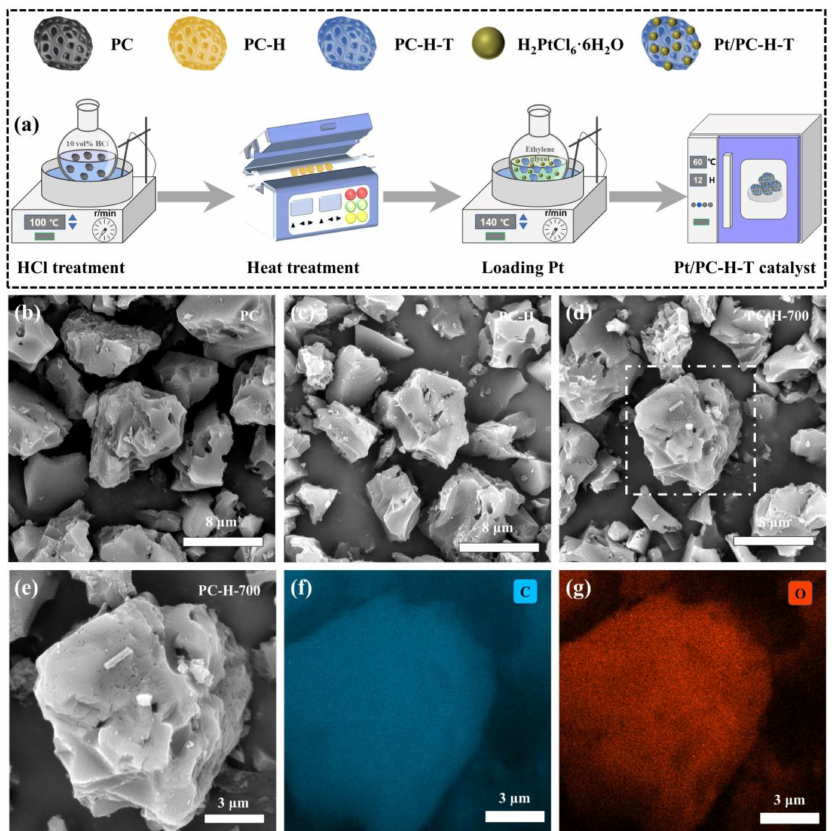
Figure 1. ( a ) Scheme representing the synthesis process of Pt/PC-H-T catalyst. SEM images of PC ( b ), PC-H ( c ), and PC-H-700 ( d ) supports. High-magnification SEM images and corresponding EDS mappings of PC-H-700 ( e – g )